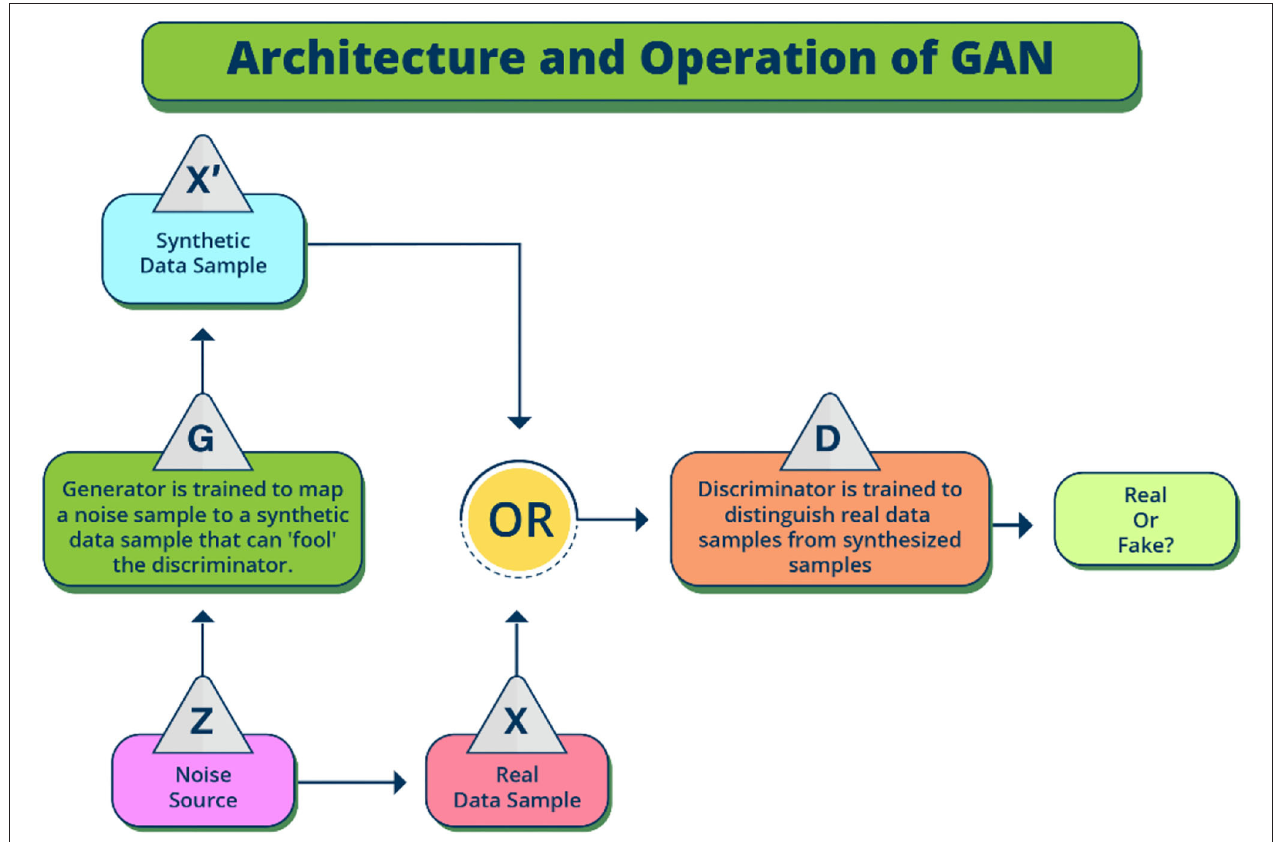
FIGURE 1 | High level description of the Generative Adversarial Network (GAN) flow architecture. Real data sample is the source, while the synthetic data sample is the target. Input noise is combined with the label in the GAN architecture, and the framework of GAN training allows the conditional GAN loss function in the generation of synthetic target